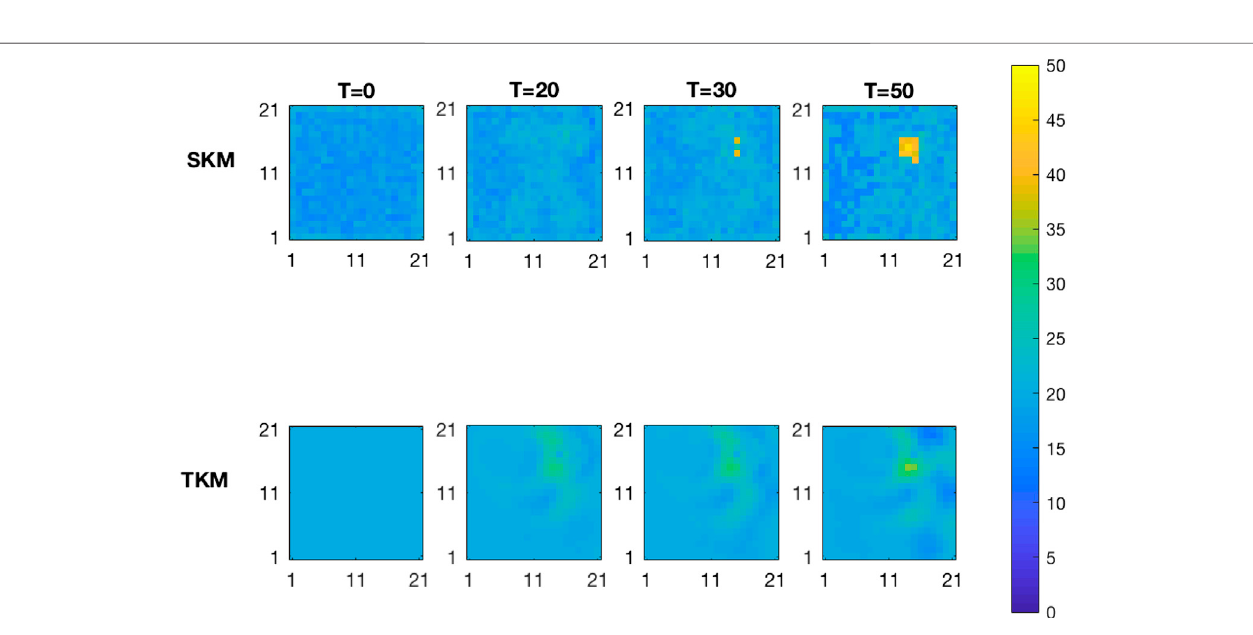
Frontiers in Applied Mathematics and Statistics |